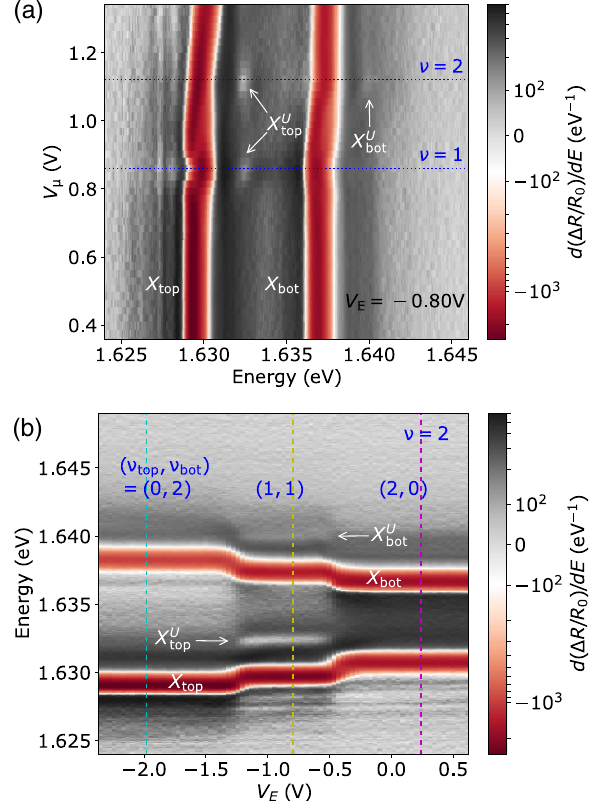
FIG. 3. Umklapp exciton resonances at ν ¼ 2 . (a) V μ depend- ence of differential reflectance differentiated with respect to ¼ − 0 . 80 V. (b) V energy E at V dependence of differential E E reflectance spectra at ν ¼ 2 . The cyan, yellow, and magenta ¼ − 1 . 98 , − 0 . 80 , and 0.24 V, dashed lines correspond to V E respectively. The scale of the color bars is logarithmic for j d ð Δ R=R Þ =dE j > 10 2 eV − 1 and linear for j d ð Δ R=R Þ =dE j < 0 0 10 2 eV − 1